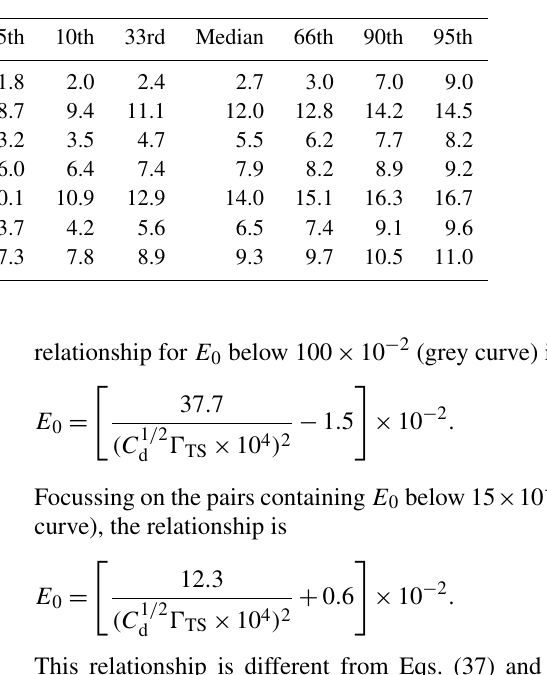
Table 11. Percentiles describing the uncertainty range of the γ TS, loc, Ant for the linear-local parameterisation and K for the other simple parameterisations after 15000 bootstrap experiments with replacement. For the Antarctic slope parameterisations, K is inferred assuming that the mean local slope is sin θ Ant = 2 . 9 × 10 − 3